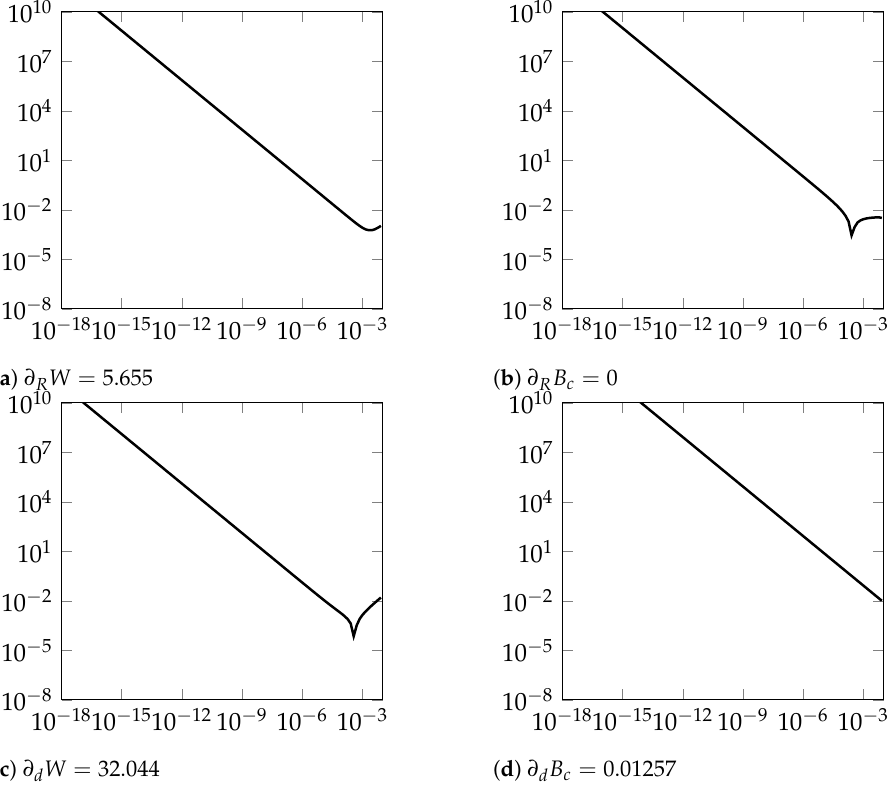
Figure 6. Relative error of the derivative computed by the finite-difference with mesh